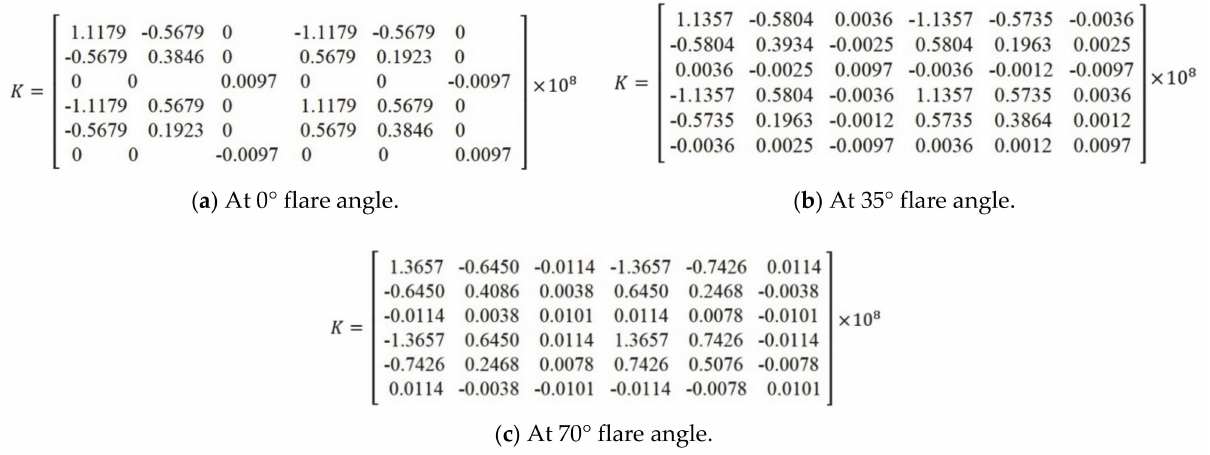
Figure 5. Stiffness matrices of the nonstandard, inboard beam element at different flare